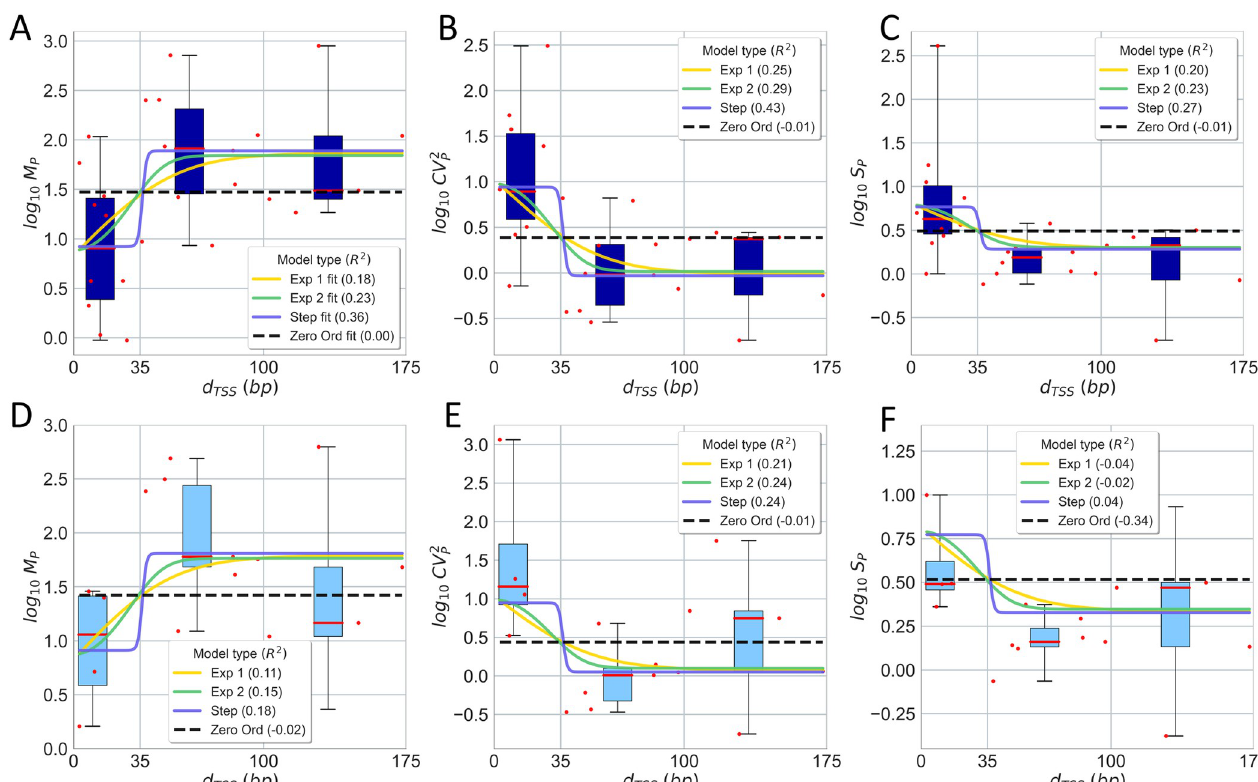
Fig 6. Empirical data and analytical model of how d TSS influences the single-cell protein numbers of genes controlled by tandem promoters. (A) Mean, (B) CV 2 , and (C) S of single protein numbers in the 1X media as a function of d . (D) , (E), and (F) show the same for the 0.5X media, respectively. Each red TSS dot is the mean from 3 biological repeats for a pair of promoters (S2 Table). The dots were also grouped in 3 ‘boxes’ based on their d TSS . In each box, the red line is the median and the top and bottom are the 3 rd and 1 st quartiles, respectively. The vertical black bars are the range between minimum and maximum of the red dots. In A , all lines are best fits. In B , C , D , E , and F , all lines are model predictions, based on the parameters used to best fit A . The insets show the R 2 for each model fit and prediction.